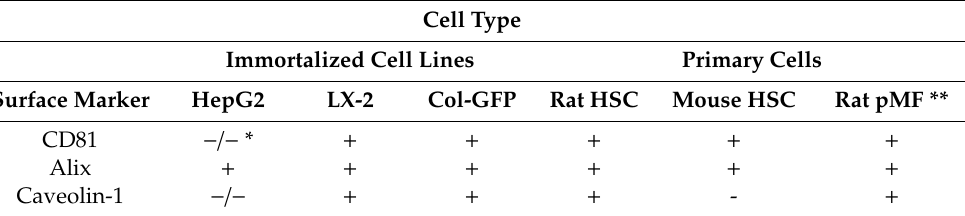
Table 2. Exosomal markers identified in liver